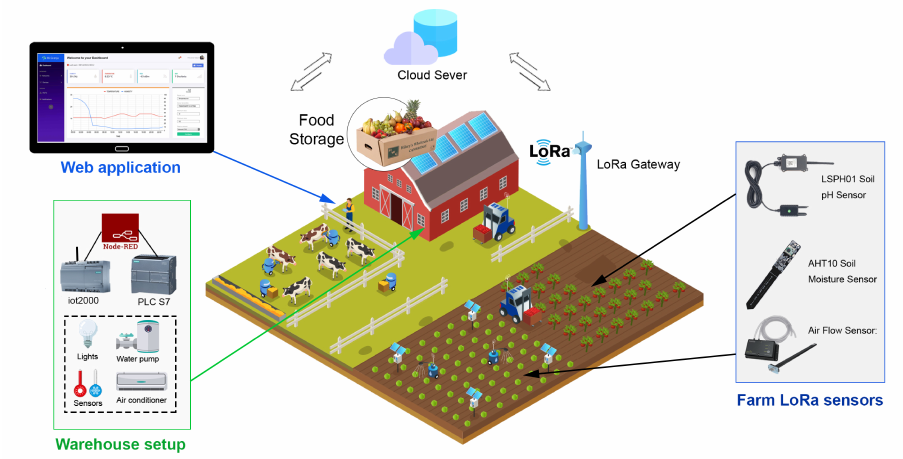
Figure 9. Illustration of the smart farming application. The proposed IoT system integrates different devices and technologies: PLC controllers and LoRa nodes connected via a gateway. The gateway forward and receive data from the cloud server that hosts the web